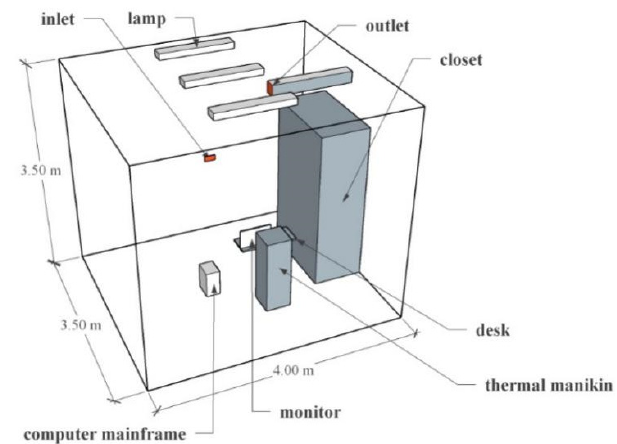
Figure 2. Configuration of the test chamber.